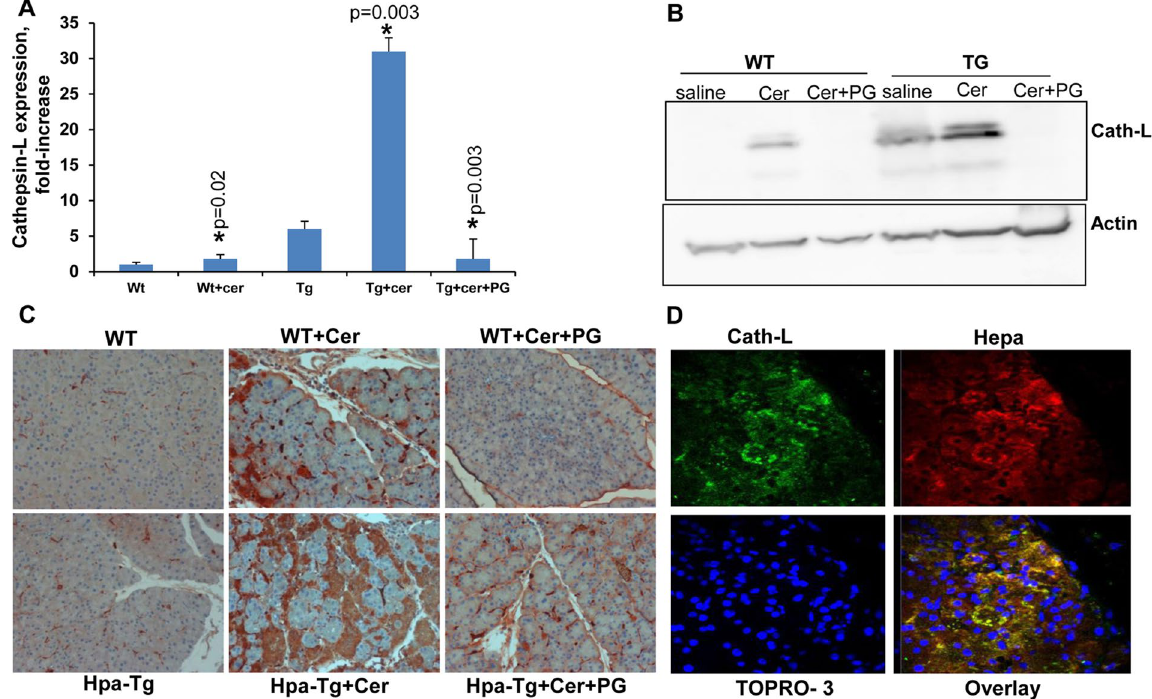
Figure 4. Cerulein induces the expression of cathepsin-L in a heparanase-dependent manner. ( A ) Real- time PCR. WT and Hpa-Tg mice were injected with saline or cerulein in the absence or presence of PG545 pretreatment. Total RNA was extracted from pancreas tissues 24 hours thereafter and subjected to real-time PCR applying primers specific for cathepsin L. Relative gene expression (fold-increase) is shown graphically in relation to the levels in control pancreas set arbitrarily to a value of 1. ( B ) Immunoblotting. Proteins were extracted from corresponding pancreas tissues and lysate samples were subjected to immunoblotting applying anti-cathepsin L (upper panel) and anti-actin (lower panel) antibodies. ( C ) Immunostaining. Corresponding paraffin embedded pancreatic tissue sections were subjected to immunostaining applying anti- cathepsin-L antibody. Note a striking increase in cathepsin L expression by cerulein which is restored by the heparanase inhibitor PG545. ( D ) Colocalization of cathepsin L and heparanase. Paraffin embedded, pancreatic tissue sections of cerulein treated Hpa-Tg mice were subjected to double immunofluorescence staining using antibodies against cathepsin L (green) and heparanase (red). Merged image is shown together with nuclei counterstaining (blue). Co-localization appears in yellow. Shown are representative photomicrographs at original magnification